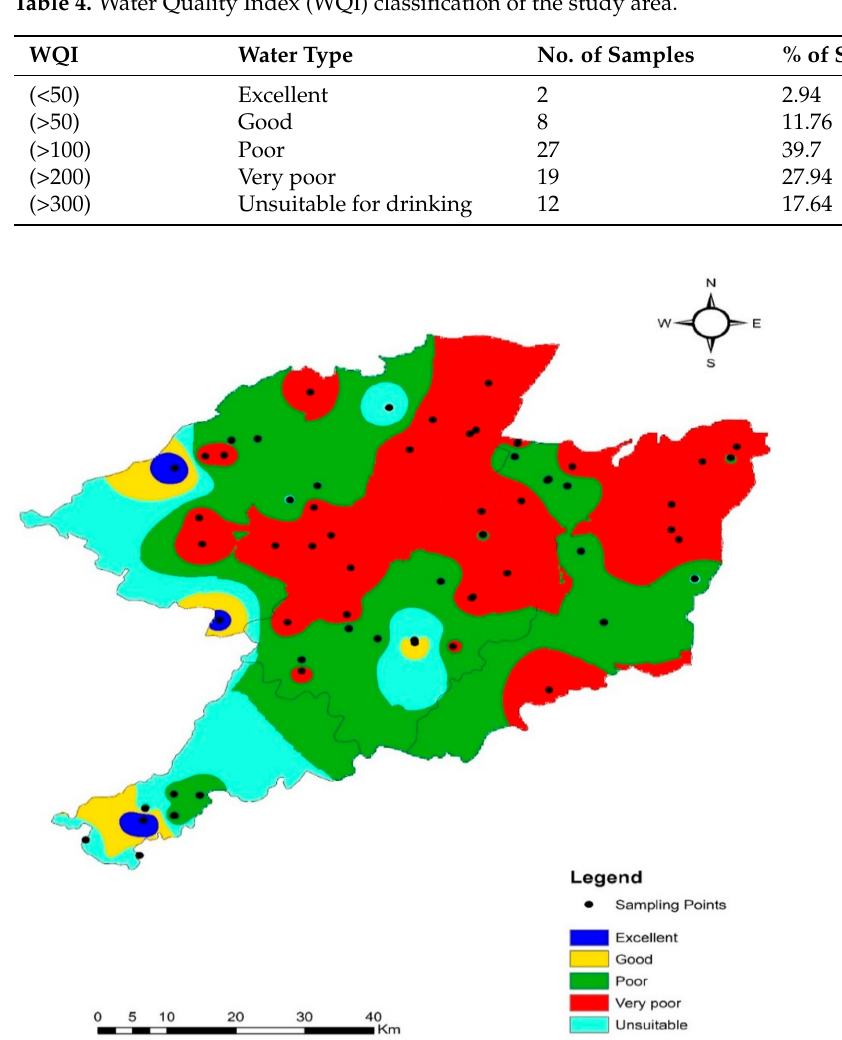
Figure 10. Groundwater suitability assessment for drinking purposes in the study